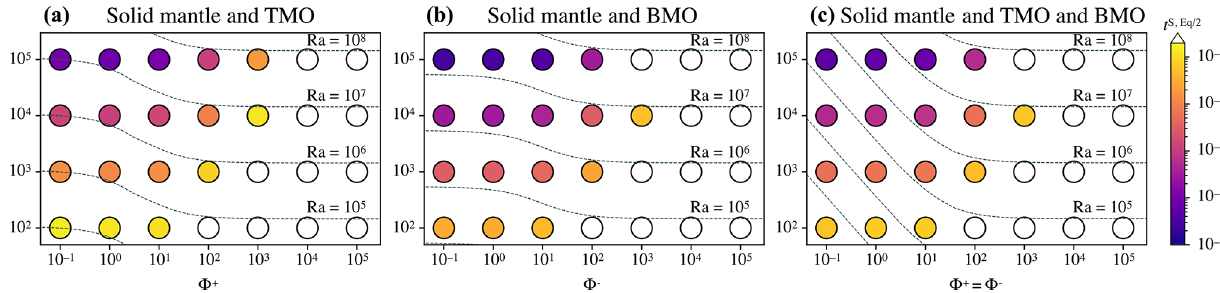
Figure 6. Timescales to reach chemical half-equilibrium (in different colours), t S, Eq/2 , between the solid mantle and (a) a top magma ocean (TMO) of 500km, (b) a basal magma ocean (BMO) of 500km, and (c) a TMO of 500km and BMO of 100km, for different values of supercriticality, SC = 10 2 − 10 5 ( Ra is indicated by dashed lines), and phase change number, (cid:56) = 10 − 1 − 10 5 . White circles are cases that did not reach chemical half-equilibrium within a reasonable runtime. Table 2. Results of the regressions of the timescales of chemical half-equilibration using the following form: t S, Eq/2 (cid:17) a 3 (cid:16) (cid:56) ± (cid:17) a 7 (cid:105) (cid:104) (cid:16) (cid:56) ± (cid:17) a 2 (cid:16) V (cid:17) a 6 (cid:16) V S S ,a 4 Ra a 5 a 0 Ra a 1 . The regression method is detailed in Appendix A. max V M V M 10 10 Regime Coefficient Solid mantle in contact with TMO BMO TMO and BMO Solid–liquid phase changes ( (cid:56) → 0) a 0 464850 103146 100473 a 1 − 1 . 042 − 1 . 008 − 1 . 000 a 2 0 . 313 0 . 176 0 . 948 − 0 . 994 − 0 . 646 Viscous building ( (cid:56) → ∞